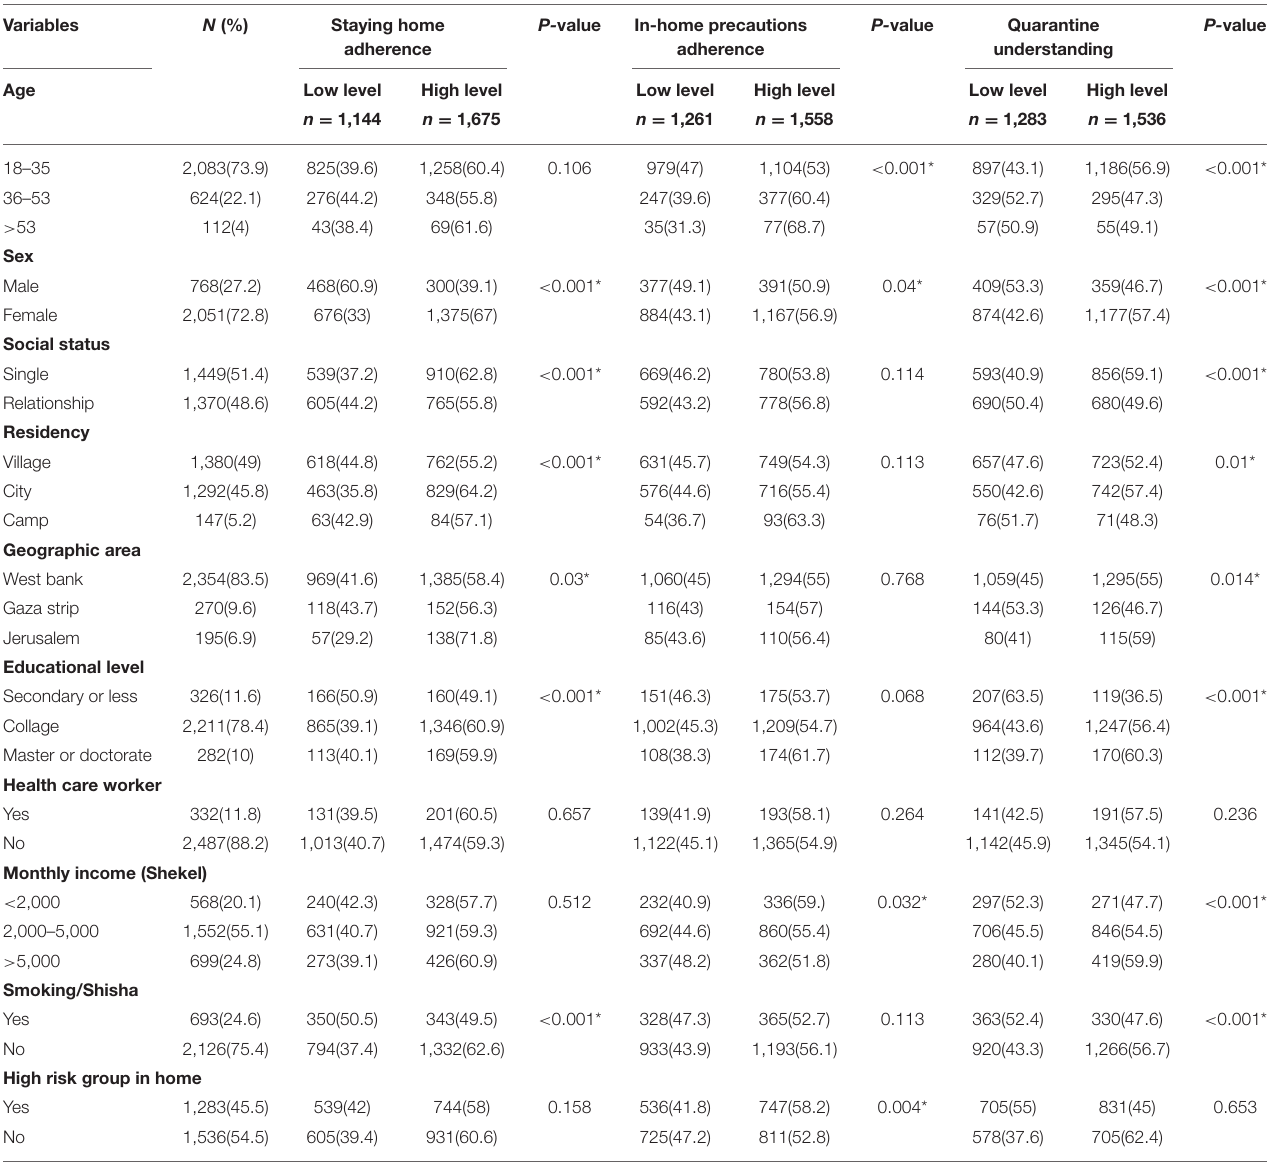
TABLE 1 | Bivariate analysis of socio-demographic characteristics with dependent variables (Staying home adherence; In-home precautions adherence; Quarantine understanding; P -value presented was Chi-square significance; N = 2,819).